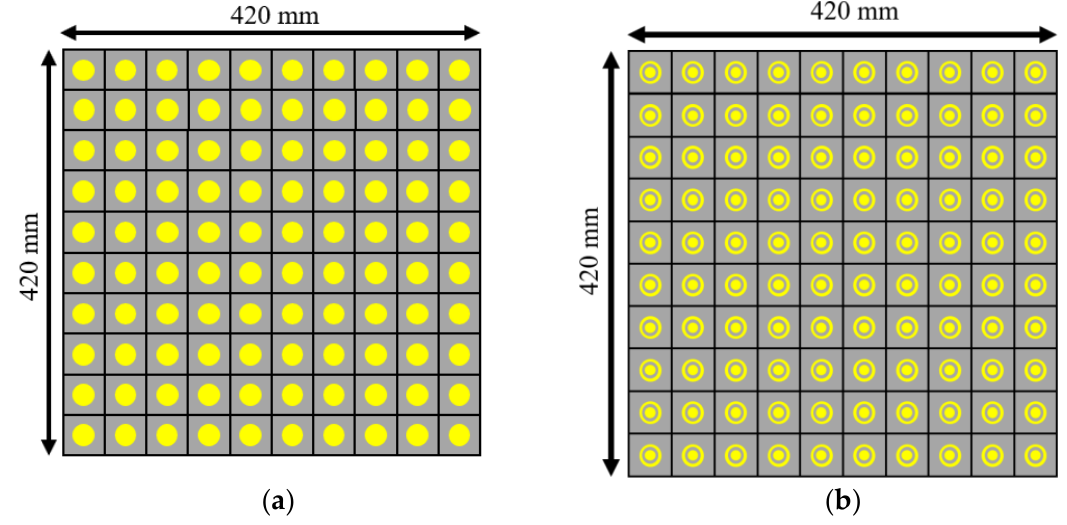
Figure 7. 10×10-unit cells array ( a ) circular type patch ( b ) circular type patch with a ring.